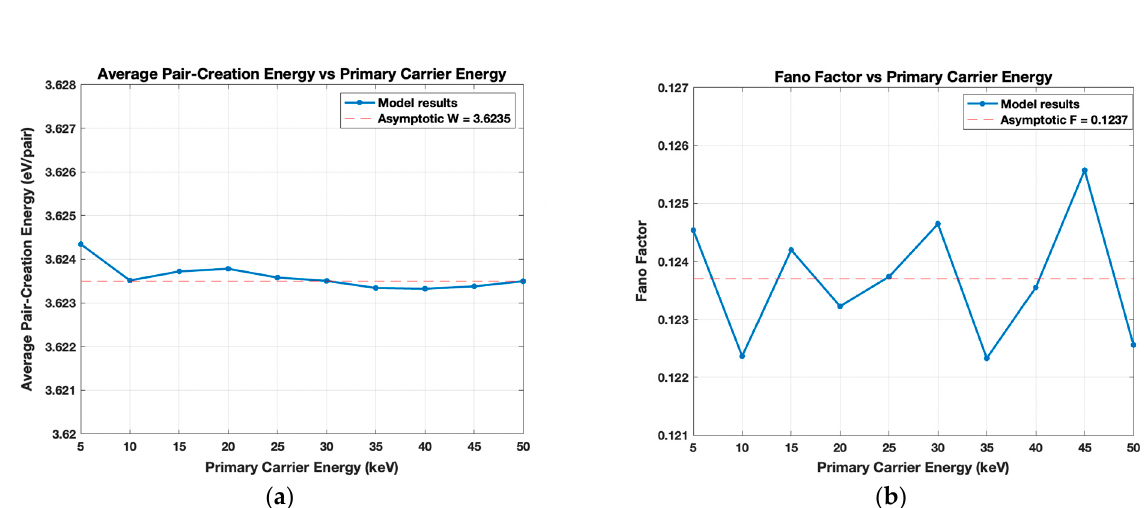
Figure 5. Cascade results as a function of 5–50 keV primary carrier energy. ( a ) The average pair-creation energy with asymptotic value ~3.63 eV/pair; ( b ) Fano Factor that fluctuates at about ~0.124.